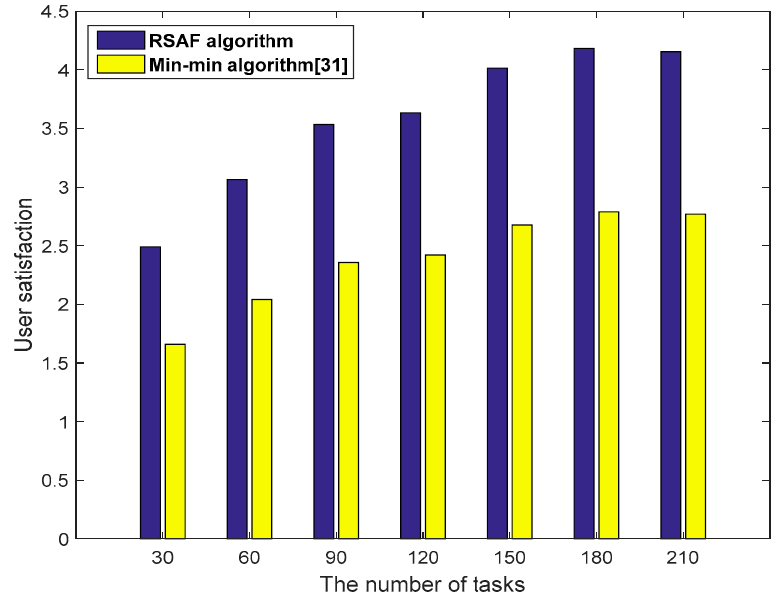
Figure 9. Comparison of user satisfaction.